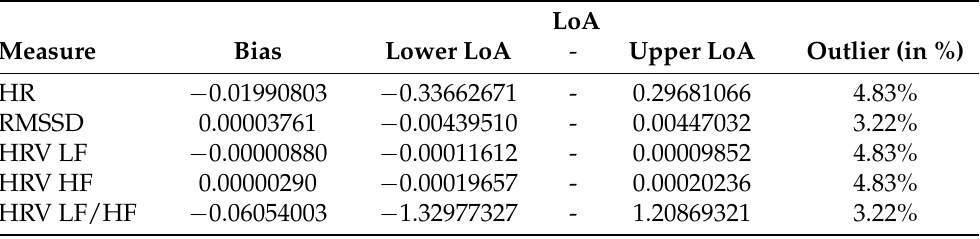
Table 7. Results of Bland–Altman absolute bias and absolute limits of agreement (LoA) for all dependent